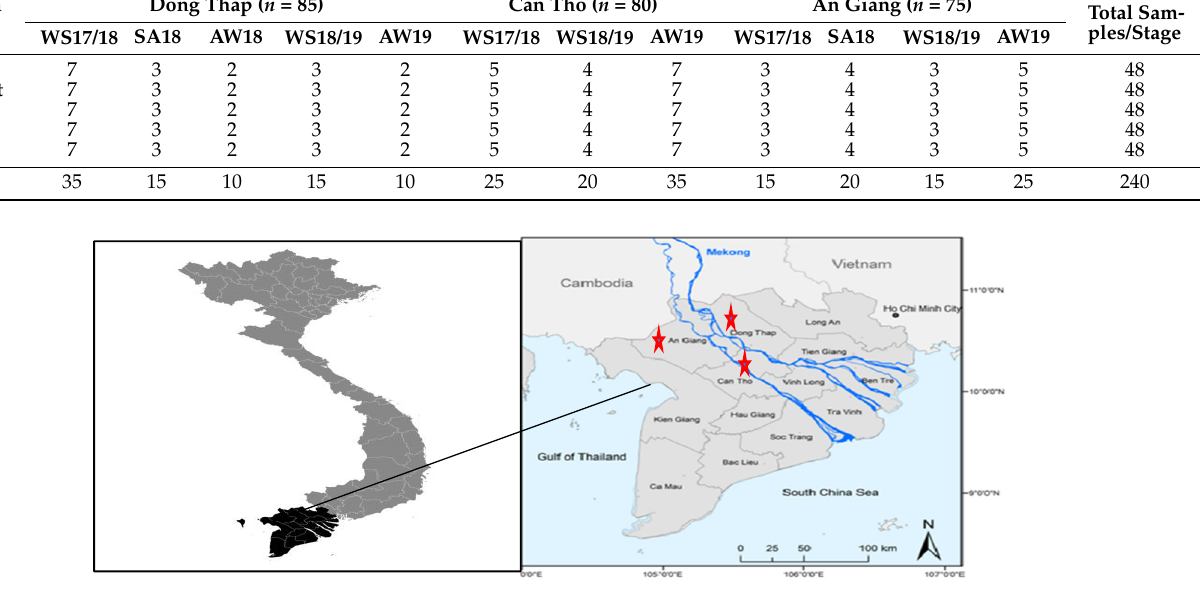
Figure 1. Sampling locations An Giang, Can Tho, and Dong Thap provinces of Mekong Delta (red stars), Vietnam.